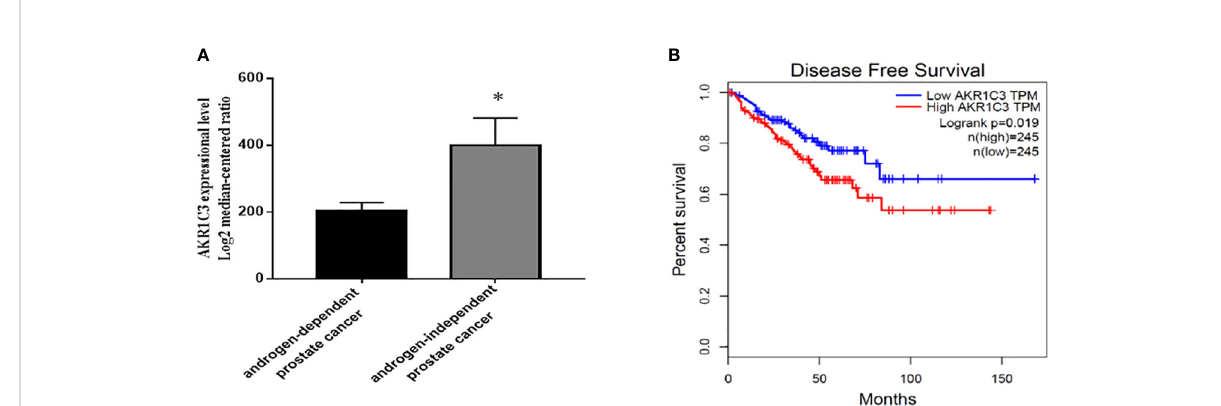
FIGURE 1 Expression level and survival analysis of AKR1C3 in PCa patients. (A) AKR1C3 gene expression analysis using the GEO database. GSE2443: androgen-dependent prostate cancer, n = 8; androgen-independent prostate cancer, n = 8; Data are presented as the mean ± SD; outliers were eliminated using a Q test. (B) Disease-free survival among PCa patients with different AKR1C3 expression levels. The plotted data are from the GEPIA database. *P <